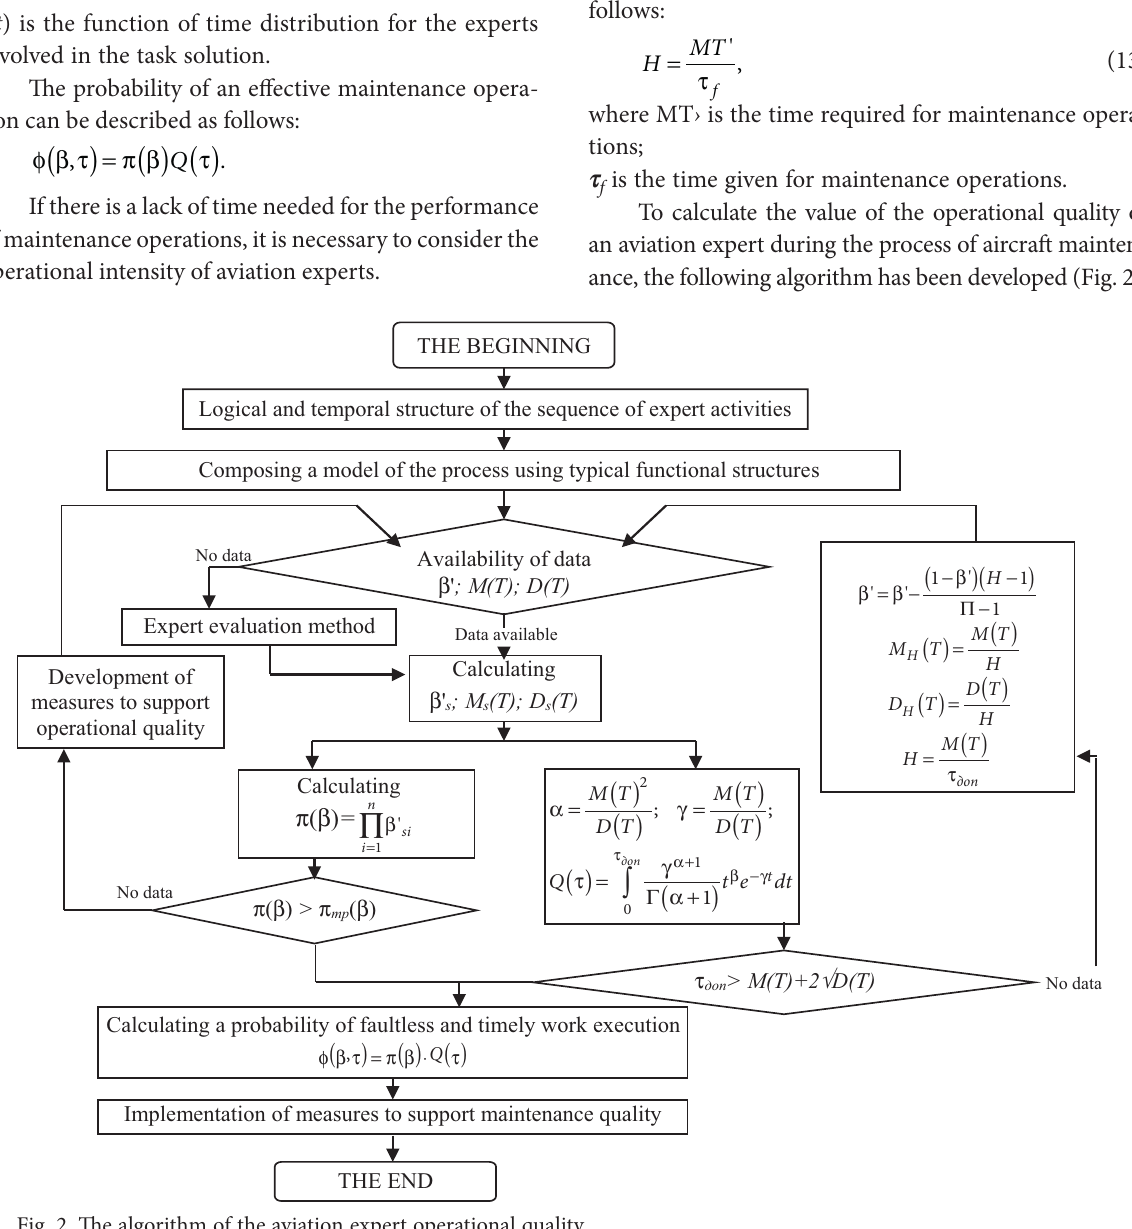
Fig. 2. The algorithm of the aviation expert operational quality